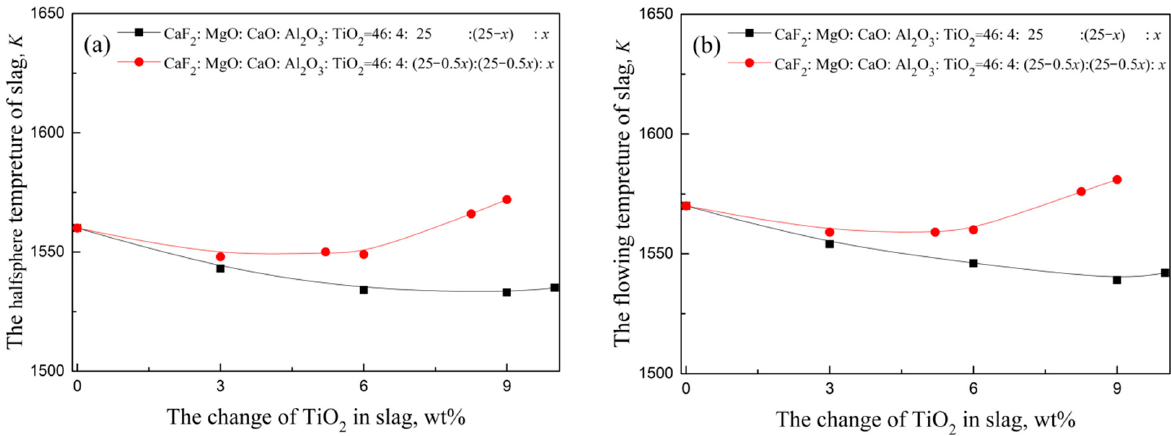
Figure 5. The change of melting temperature with different S0:F1 and S0:F2 ratios: ( a ) halfsphere temperature, and ( b ) flowing temperature.